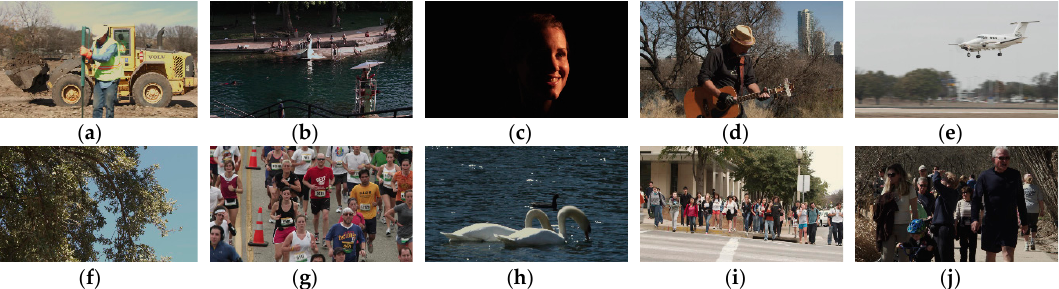
Figure 1. First frame, laboratory for image and video engineering (LIVE) mobile database: ( a ) bulldozer with fence, ( b ) Barton Springs pool diving, ( c ) friend drinking Coke, ( d ) Harmonicat, ( e ) landing airplane, ( f ) panning under oak, ( g ) Runners skinny guy, ( h ) two swans dunking, ( i ) students looming across street, ( j ) trail pink kid.